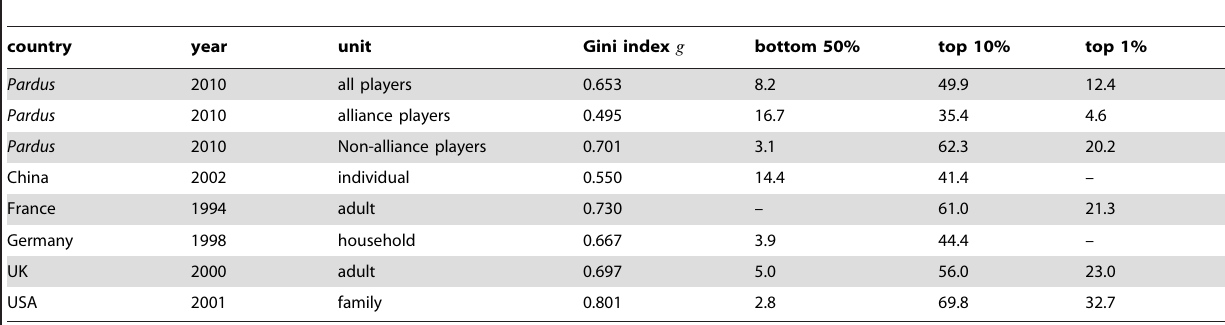
Table 1. Measures of wealth-inequality in Pardus compared to real-world countries.